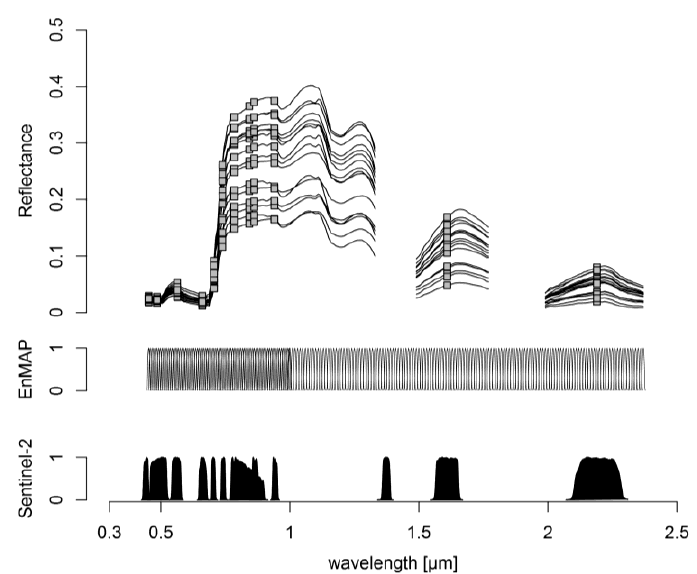
Figure 2. Simulated EnMAP (lines) and Sentinel-2 spectra (squares) of various tree species and stand structures in comparison to the spectral response functions used for generating the datasets based on interpolated HyMap reflectance